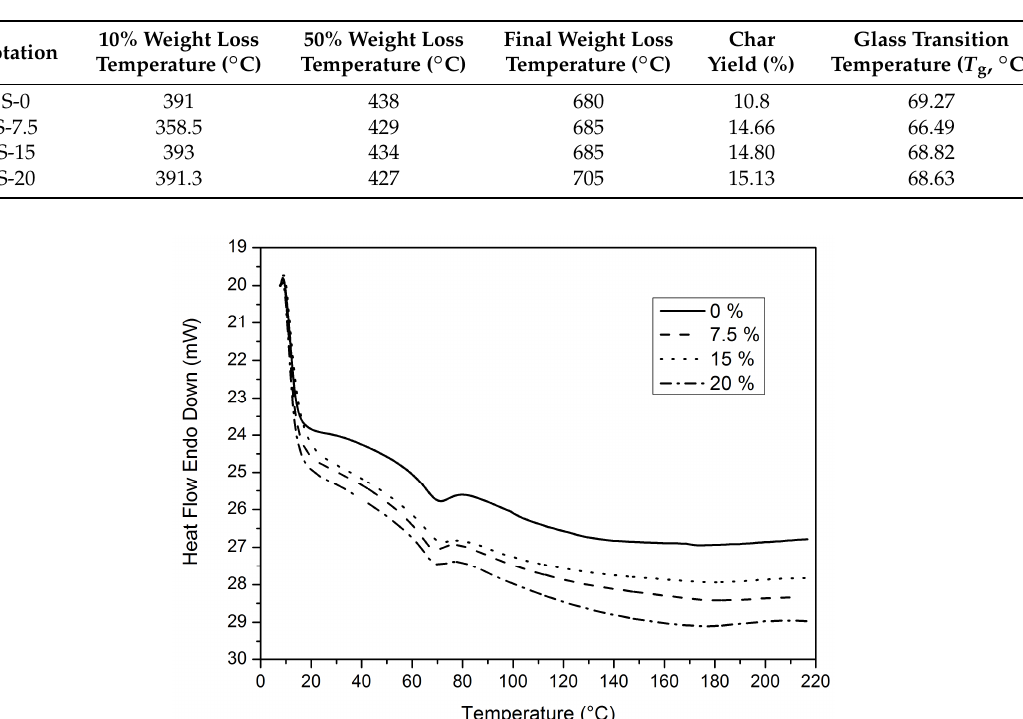
Figure 7. DSC curves of UV ‐ curable hybrid films.